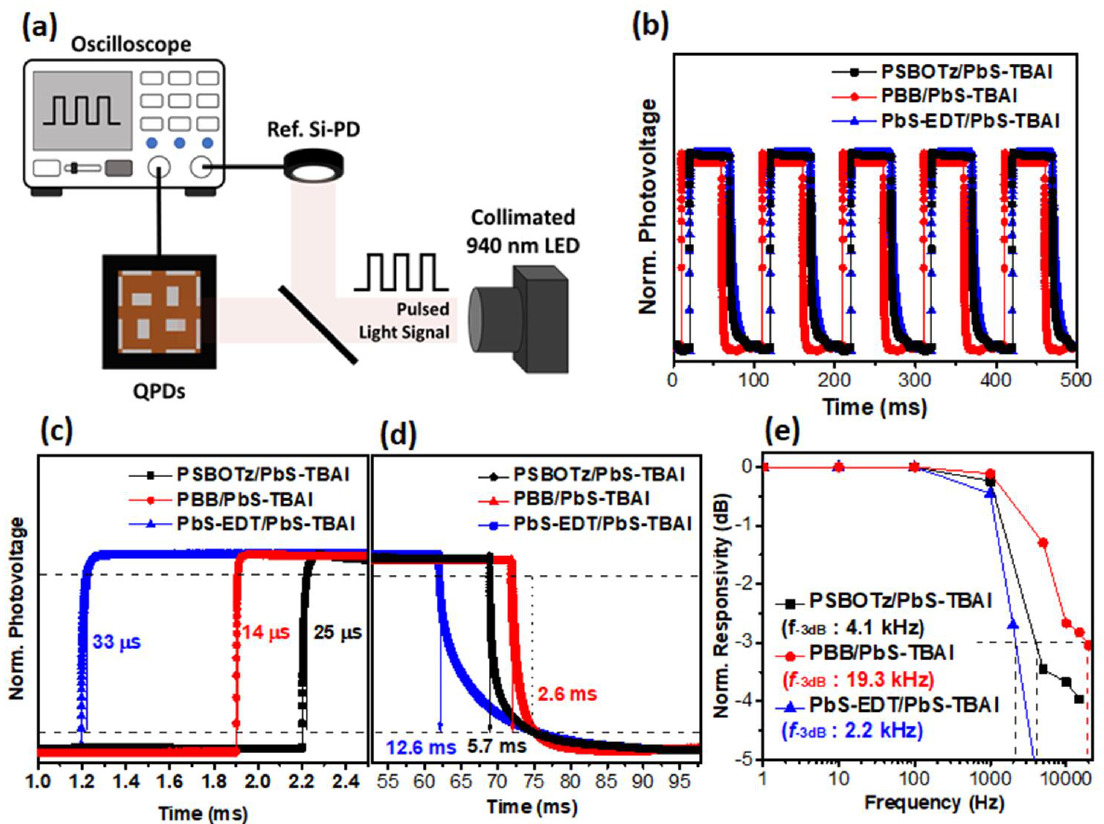
Figure 3 . ( a ) Schematic of transient photovoltage characterization system. ( b ) TPV results for each device, and ( c ) ris- ing response time and ( d ) falling response time enlarged from Figure 3b. ( e ) The −3 dB frequency plots under modu- lated 940 nm LED at −1.0 V